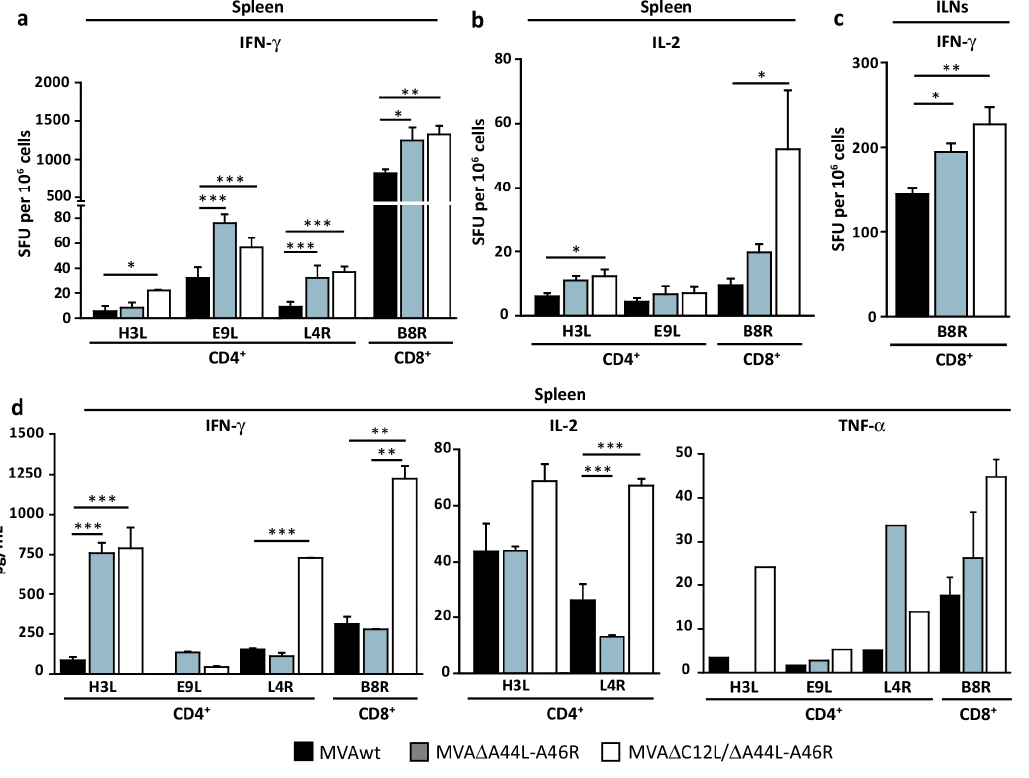
Figure 4. Deletion of specific VACV genes improved adaptive T-cell response during memory phase. Groups of four C57Bl/6 mice were immunized and 45 dpi specific T-cell responses against VACV-peptides were evaluated in spleen ( a , b ) and ILNs ( c ). Specific responses were evaluated by IFN- γ ( a , c ) and IL-2 ( b ) ELISPOT. Specific cytokine production in splenocyte-culture supernatants was evaluated by ELISA ( d , left and middle panel) or CBA ( d , right panel) after stimulation with VACV-peptides. Data are expressed as mean + SD of triplicate ( a – c ) or duplicate ( d ) determinations, and are representative of three independent experiments. Statistical analysis performed by one-way ANOVA and Bonferroni’s post-test. Significant differences: * p < 0.05, ** p < 0.01, *** p < 0.001.